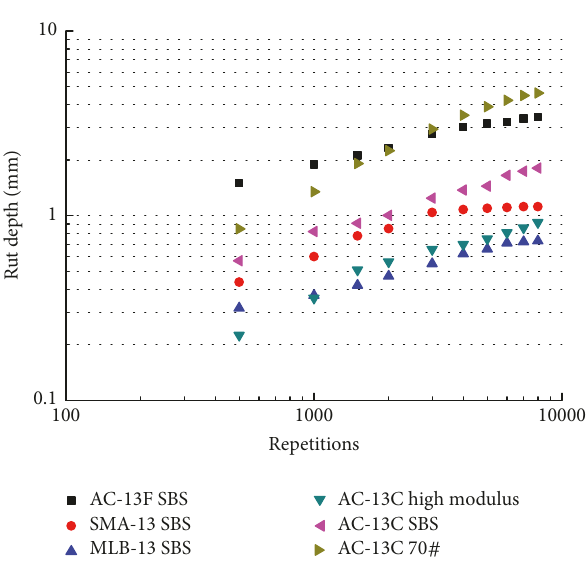
Figure 7: Average cumulative APA